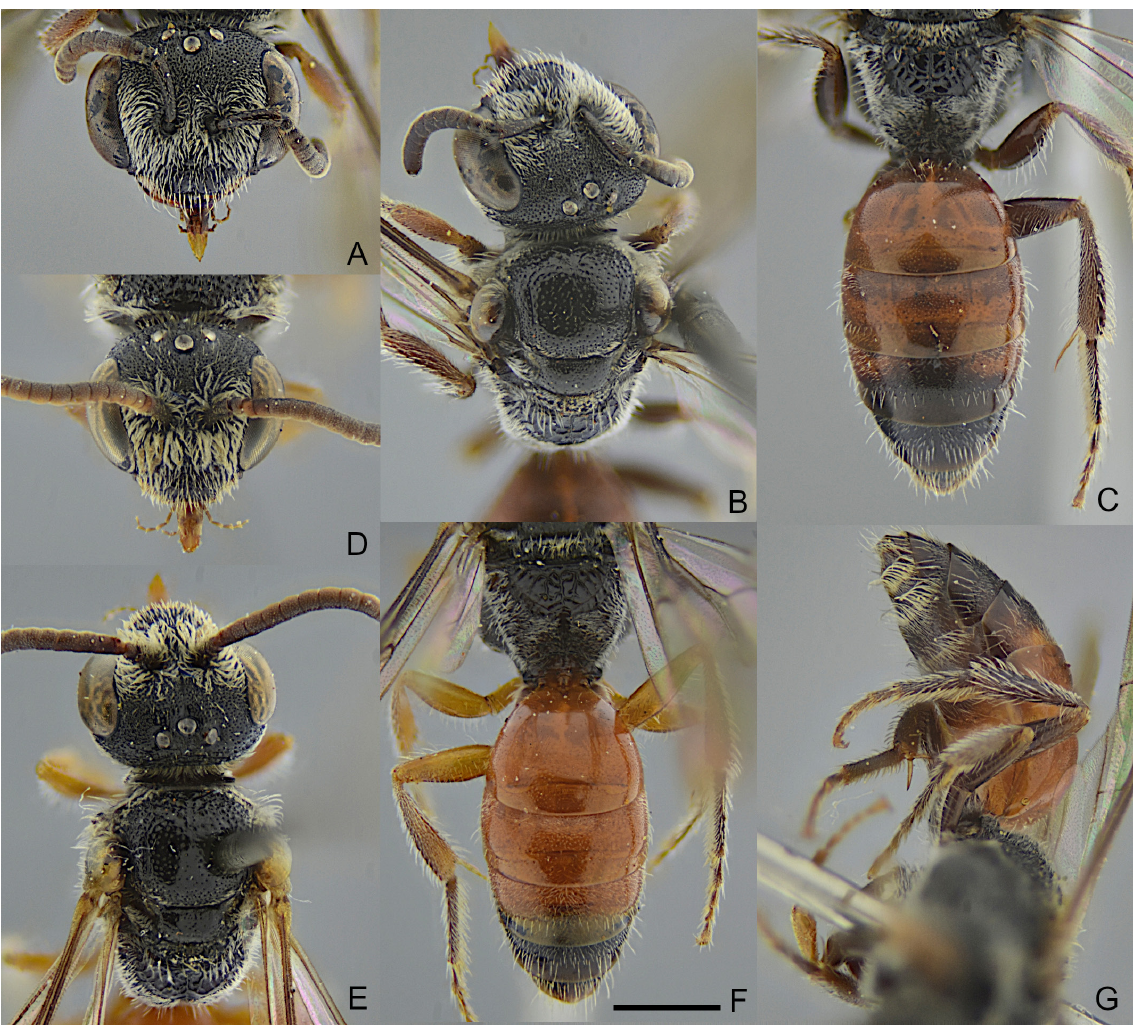
Fig. 8. Austrosphecodes orcus sp. nov. A – C . Paratype (DZUP 568527). D – F . Holotype, ♂ (DZUP 568538). A . Female head. B . Female mesosoma. C . Female propodeum and metasoma. D . Male head. E . Male mesosoma. F . Male propodeum and metasoma. G . Male metasomal sterna. Scale bar = 1